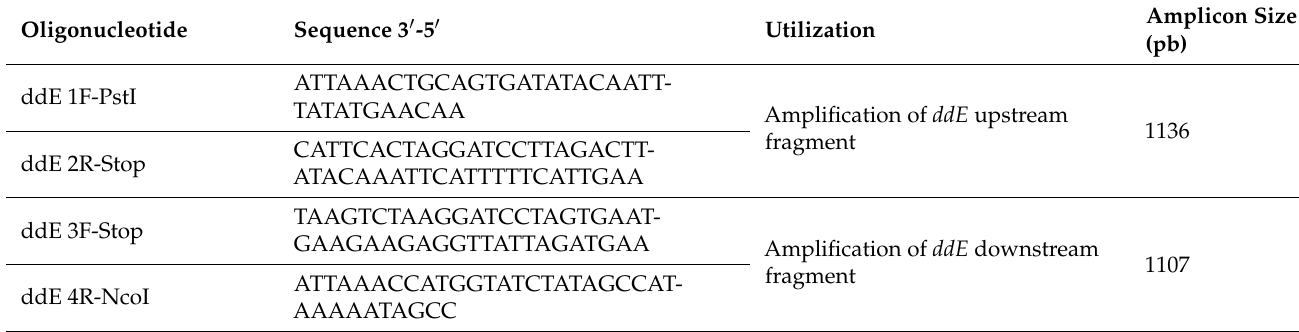
Table 5. List of oligonucleotides used in this